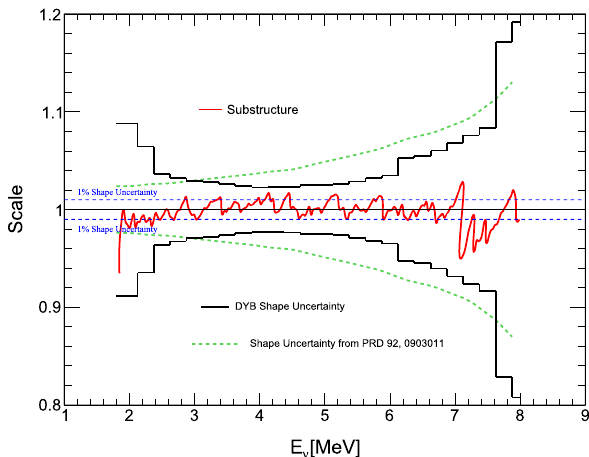
Fig. 4 Comparison of our estimated scale of fine structure (red) with the current uncertainties of the Daya Bay measured (black) spectrum [23]. We also plot the expected shape uncertainty (1%) in the literatures [14,42,43](bluedashedlines)aswellasthesmoothedandsymmetrized uncertainty from [27] as a comparison (the dashed green